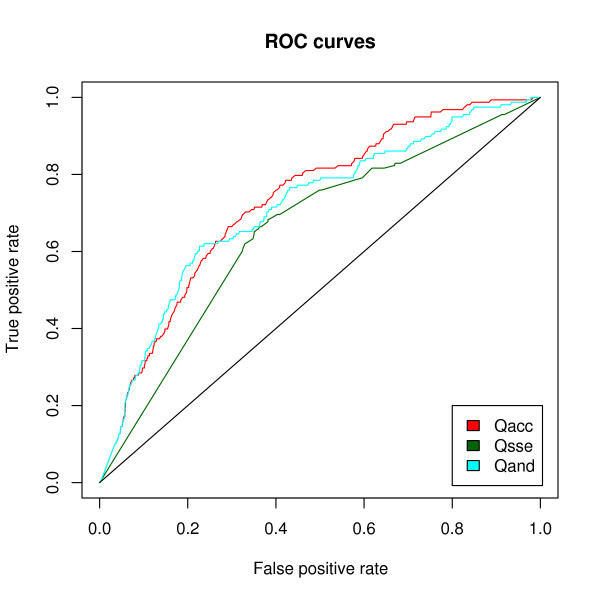
Qacc, Qsse and Qand = Qacc+ Qsse ROC curves.